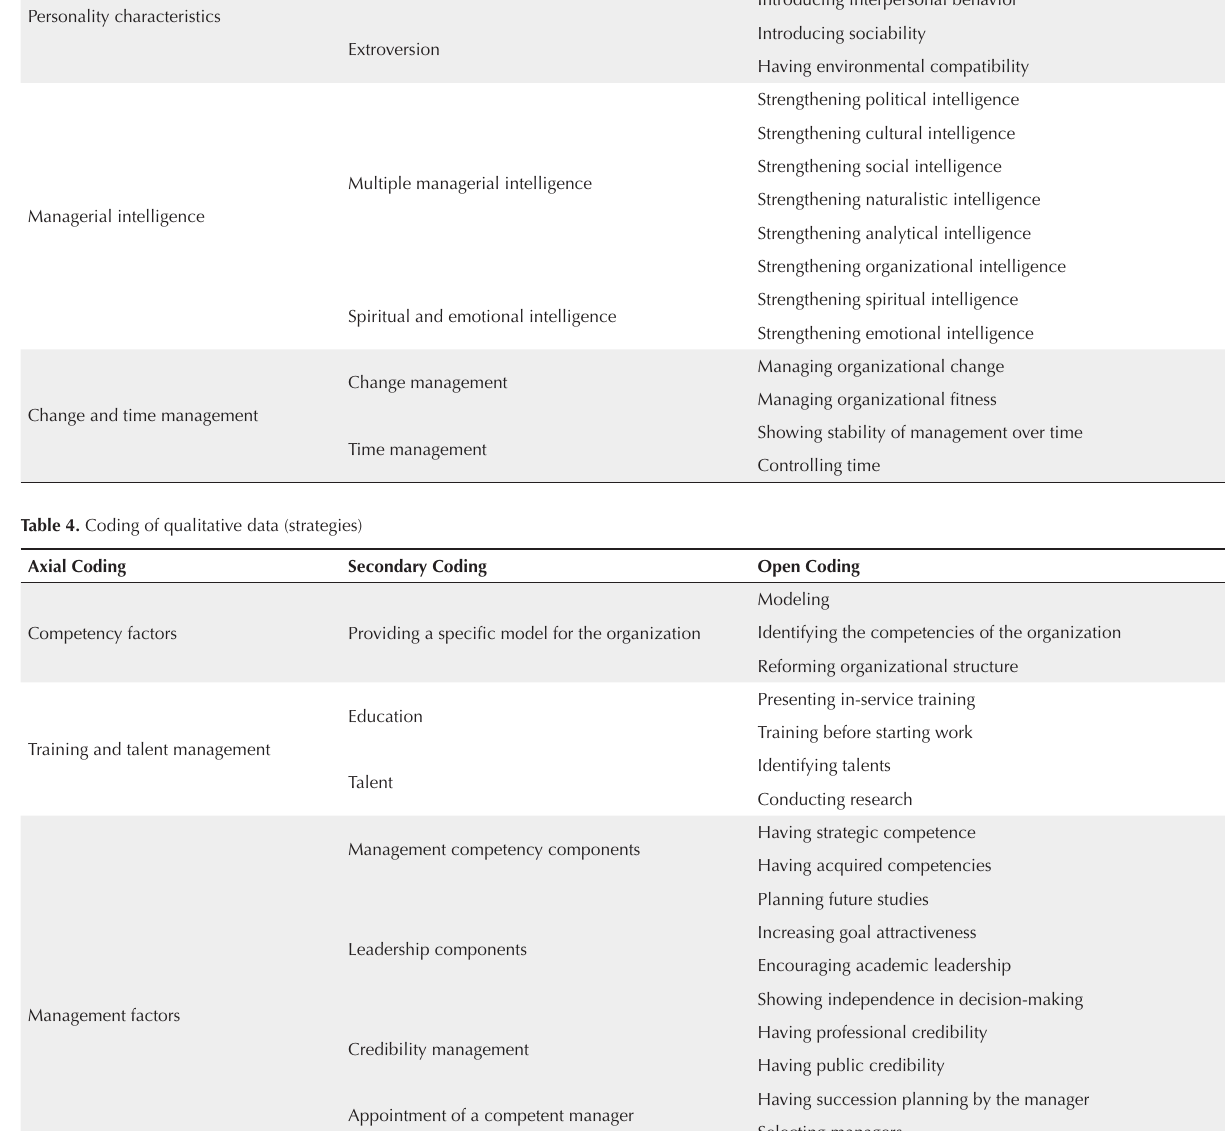
Table 3. Axial coding of qualitative data (intervening conditions)